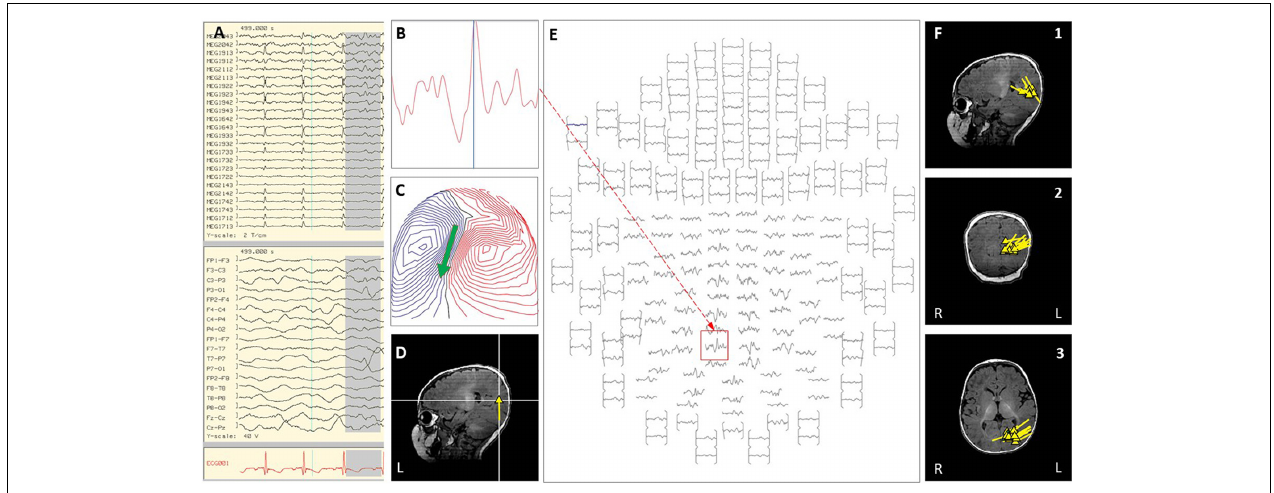
FIGURE 4 | Case 7 (A–E) provide an example of an individual simultaneous MEG–EEG seizure onset in the left interhemispheric area. (B) Selected MEG channel and time instance of the magnetic field distribution (C) in sensor space with the projected source estimate (back of the head, green arrow). The sagittal MRI slices (D) indicates the origin (triangle) and source orientation (tail) of the spike discharge. The MEG channel plot (E) of the selected time interval as shown in (A) shows the region of interest and the planar gradiometer channel (red squared box) with the earliest peak time. The summary pictures (F1–F3) give an impression of the epileptiform activity (yellow triangles) originating all from the left mesial occipital